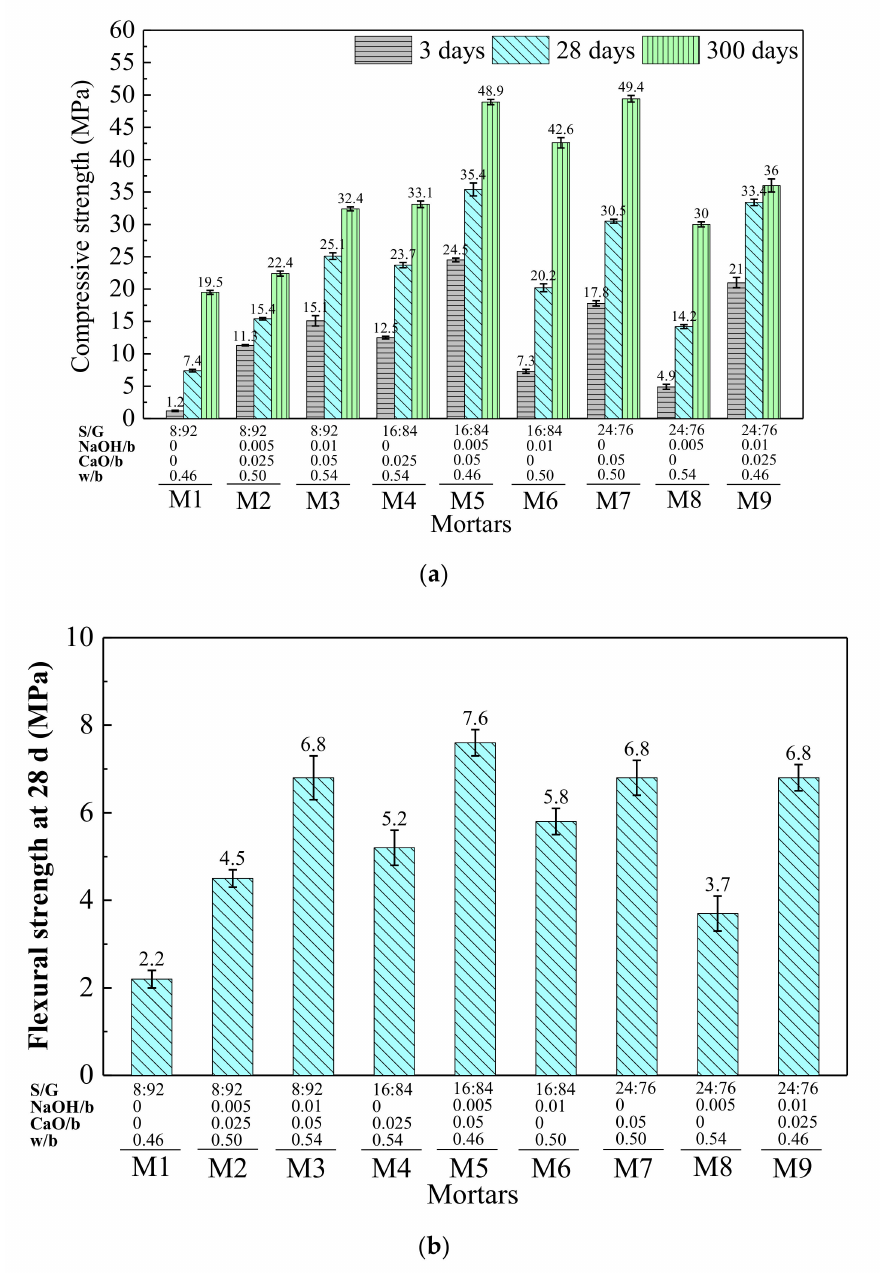
Figure 3. Orthogonal experiment results of ( a ) compressive strength at 3, 28, and 300 d; ( b ) flexural strength at 28